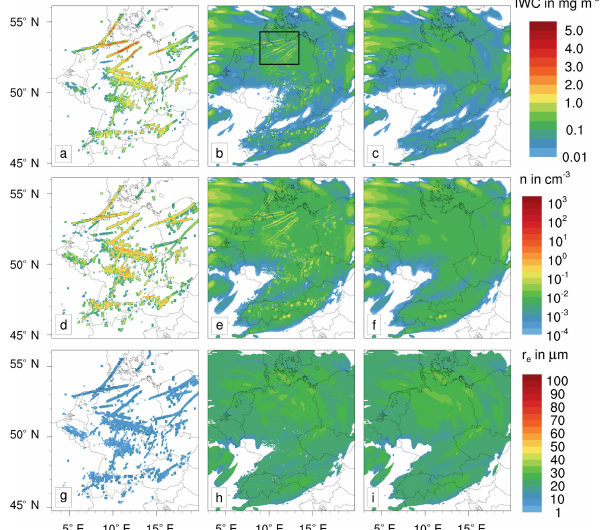
Figure 3. Various ice cloud properties are depicted for 10:00UTC at an altitude of 11900m (top row: ice water content; center row: ice crystal number concentration; bottom row: effective radii). De- picted are the simulation with aviation (left column: contrail ice class; middle column: cirrus ice class) and without aviation (right column).